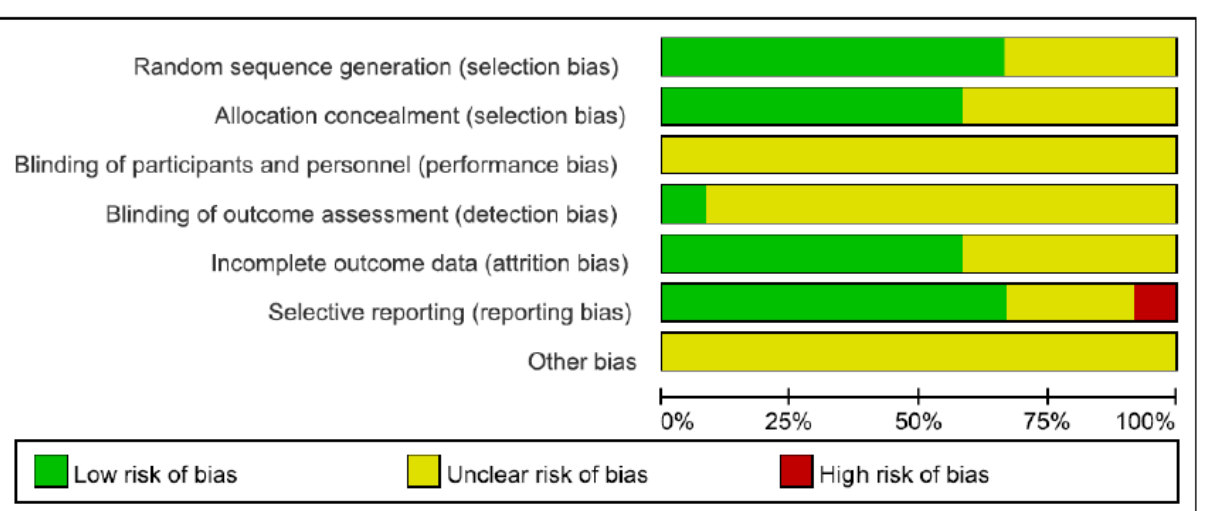
Figure 2. Risk of bias graph.